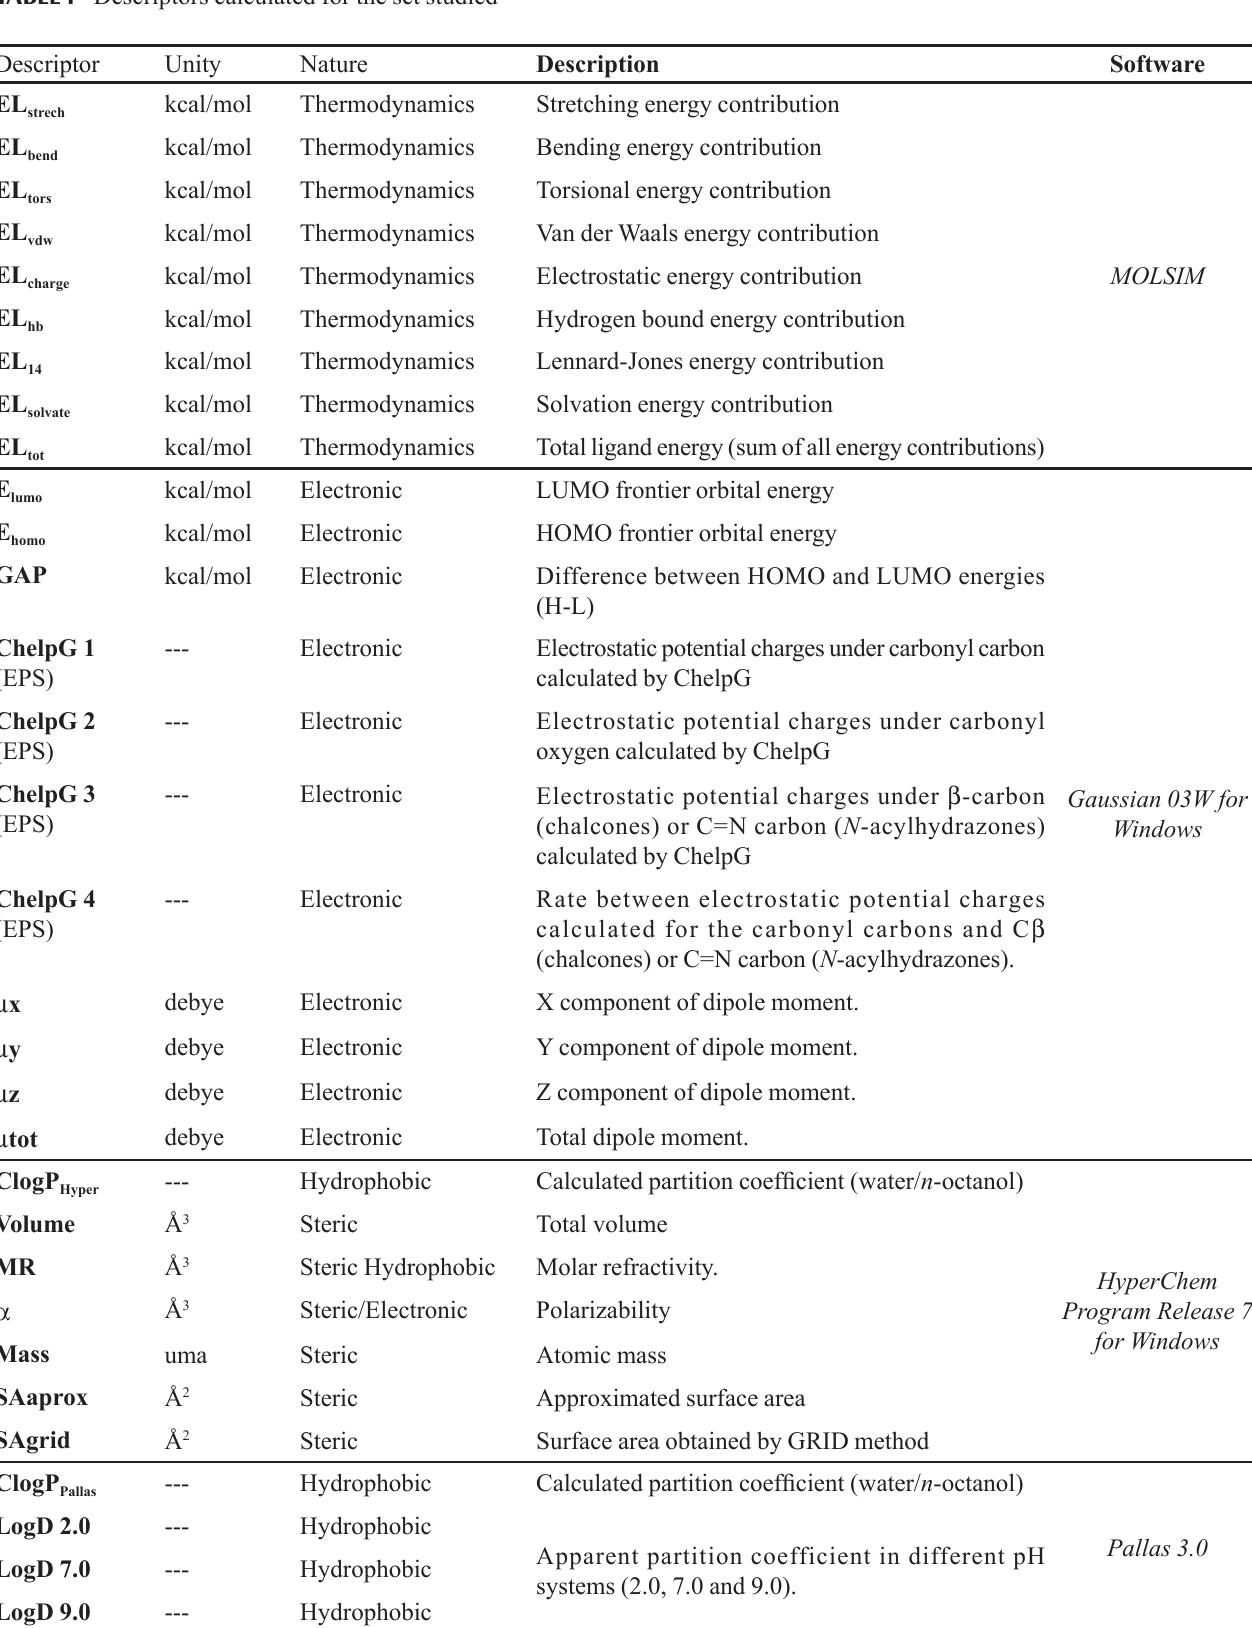
TABLE I - Descriptors calculated for the set studied